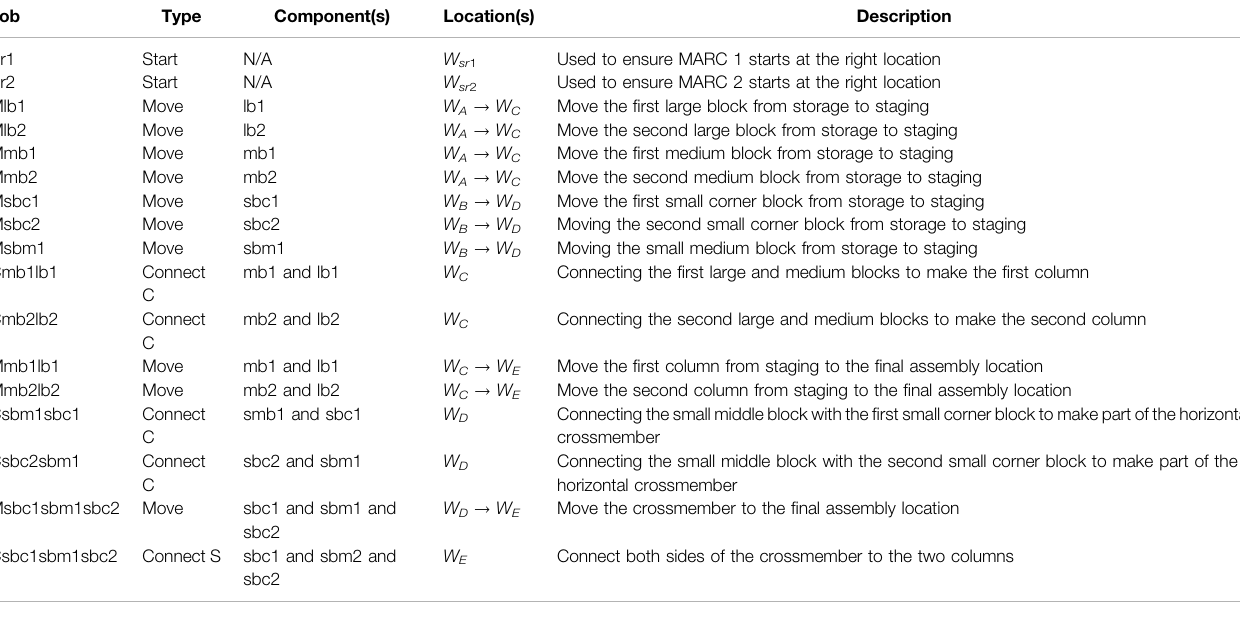
TABLE 5 | Jobs in the arch assembly project.